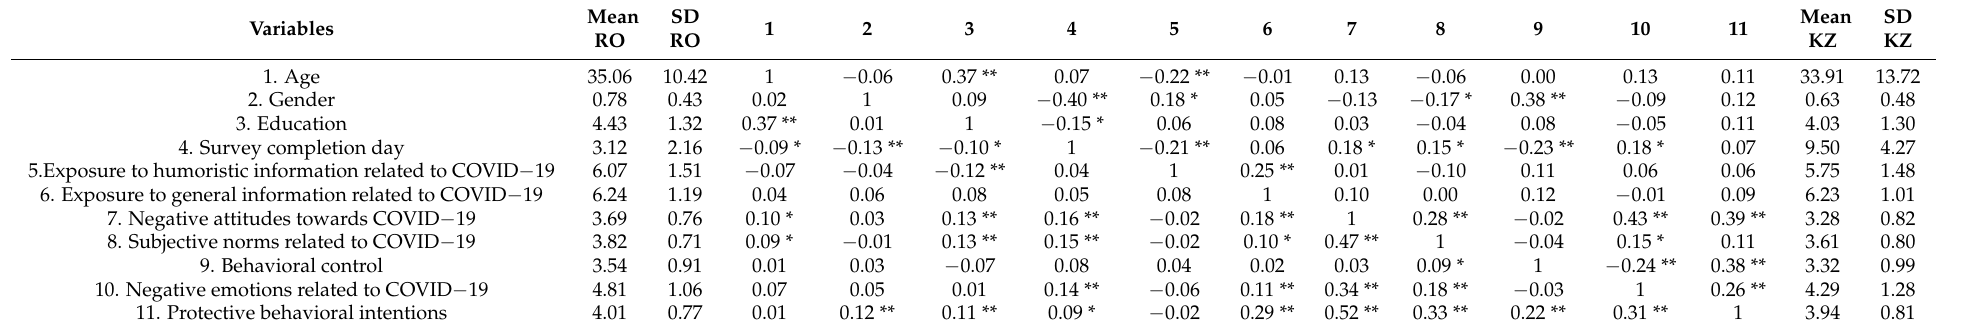
Table 1. Means, standard deviations and